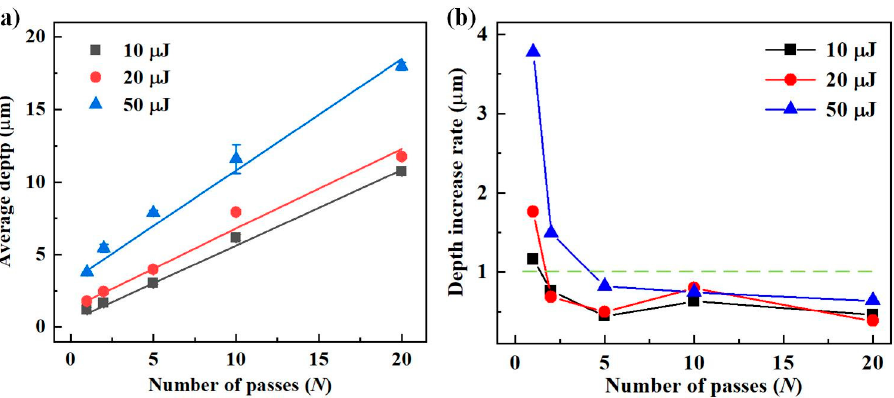
Figure 13. E ff ect of the number of passes on the depth of the microgrooves. ( a ) Variation in the average depth of microgrooves with the number of passes. ( b ) The depth increase rate in the micro- groove varies depending on the number of passes.